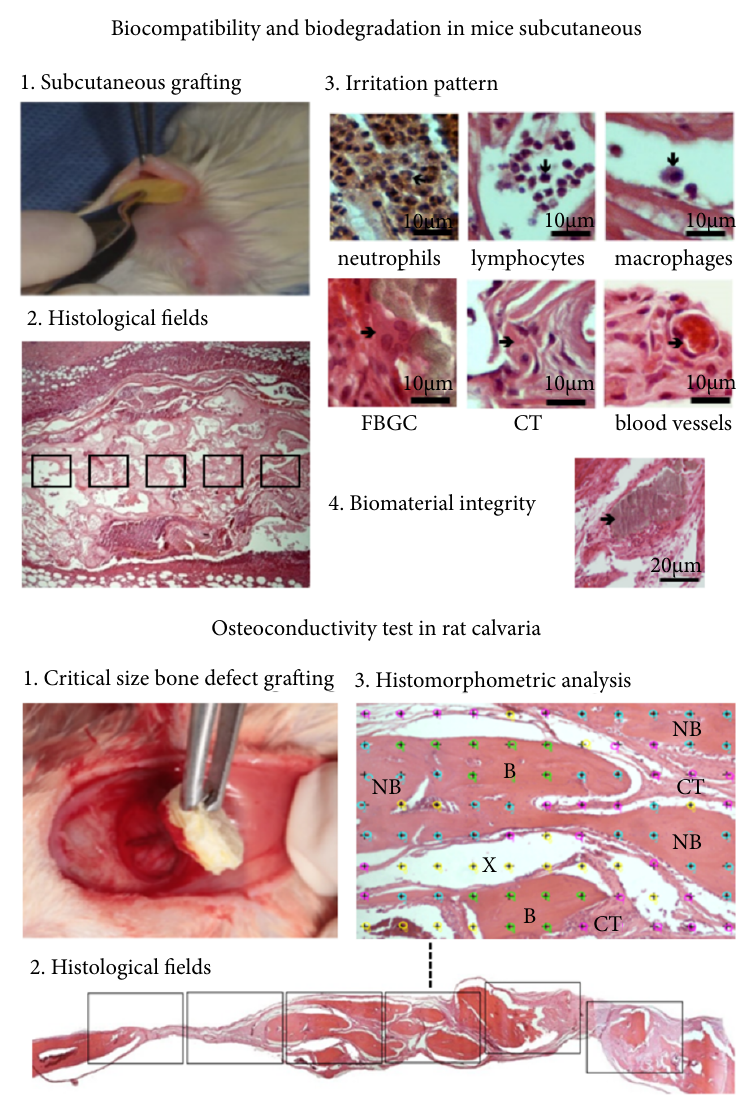
Figure 1 - Steps of the